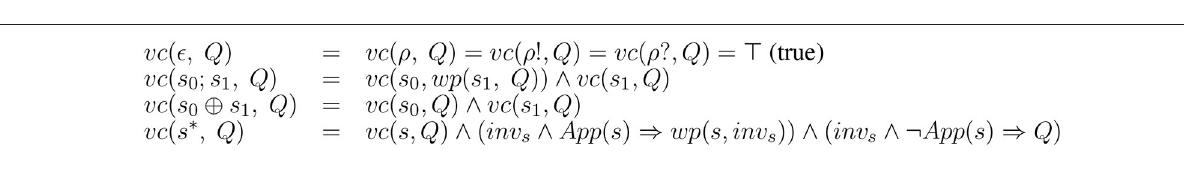
Figure 4 . ACESO contains the axiom Symmetric ( lives_with )